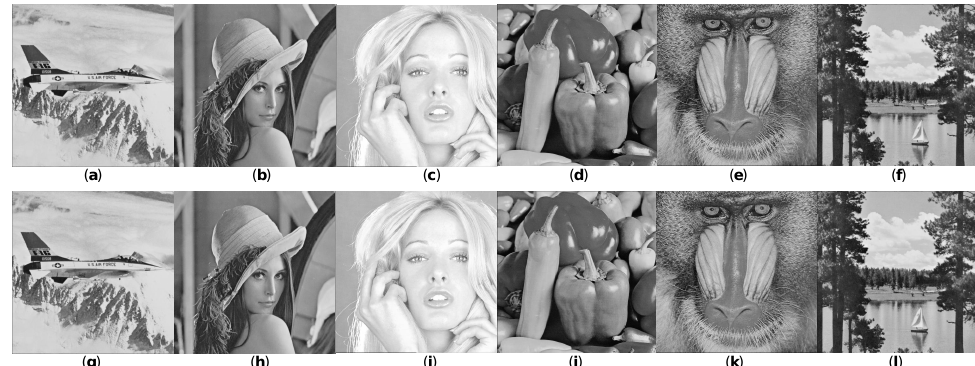
Figure 6. Examples for the marked images: ( a ) Airplane with 10,000 bits, ( b ) Lena with 10,000 bits, ( c ) Tiffany with 10,000 bits, ( d ) Peppers with 10,000 bits, ( e ) Baboon with 10,000 bits, ( f ) Sailboat with 10,000 bits, ( g ) Airplane with 20,000 bits, ( h ) Lena with 20,000 bits, ( i ) Tiffany with 20,000 bits, ( j ) Peppers with 20,000 bits, ( k ) Baboon with 20,000 bits, and ( l ) Sailboat with 20,000